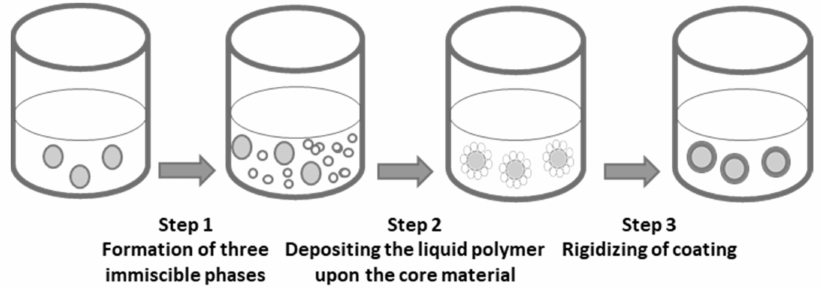
Figure 10. Schematic representation of the different stages of the microencapsulation process by coacervation